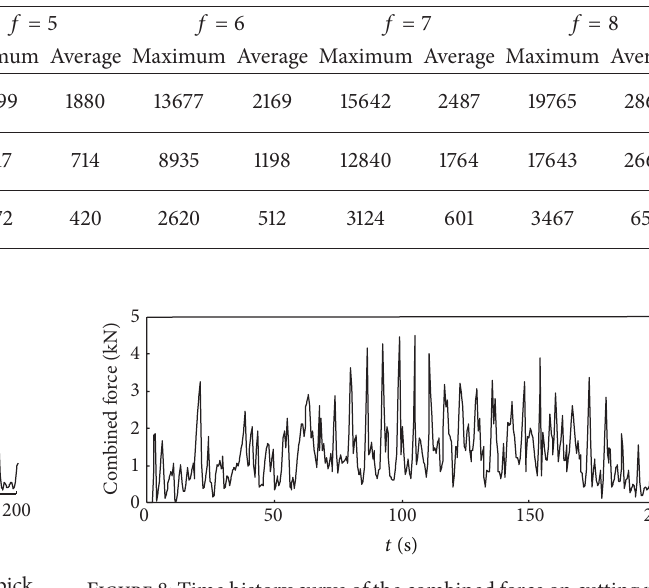
Figure 8: Time history curve of the combined force on cutting pick.